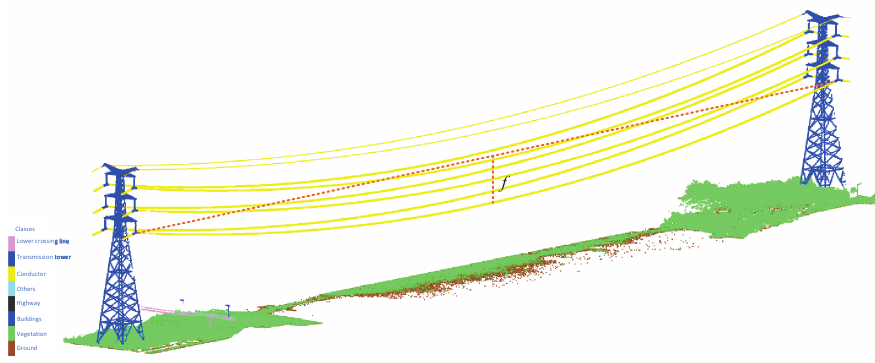
Figure 4. The catenary curve and sag of overhead transmission